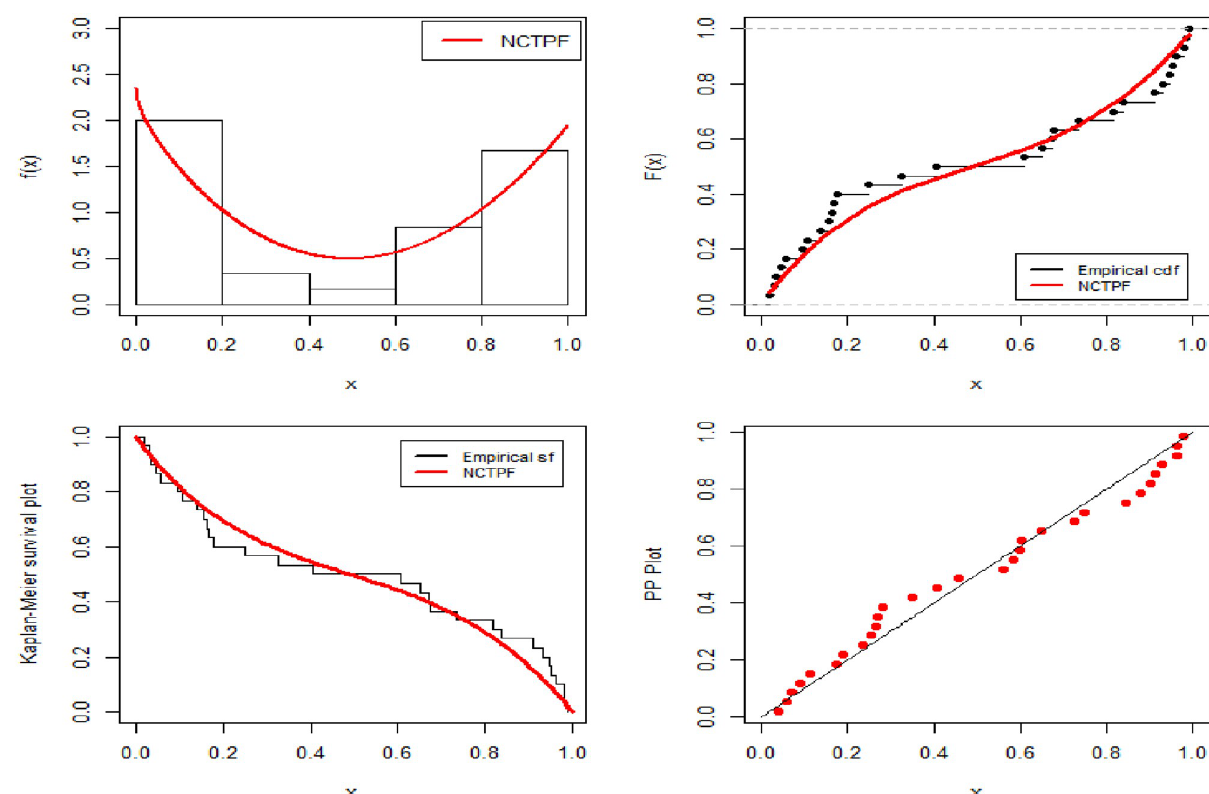
Fig 4. Fitting performance of the NCTPF